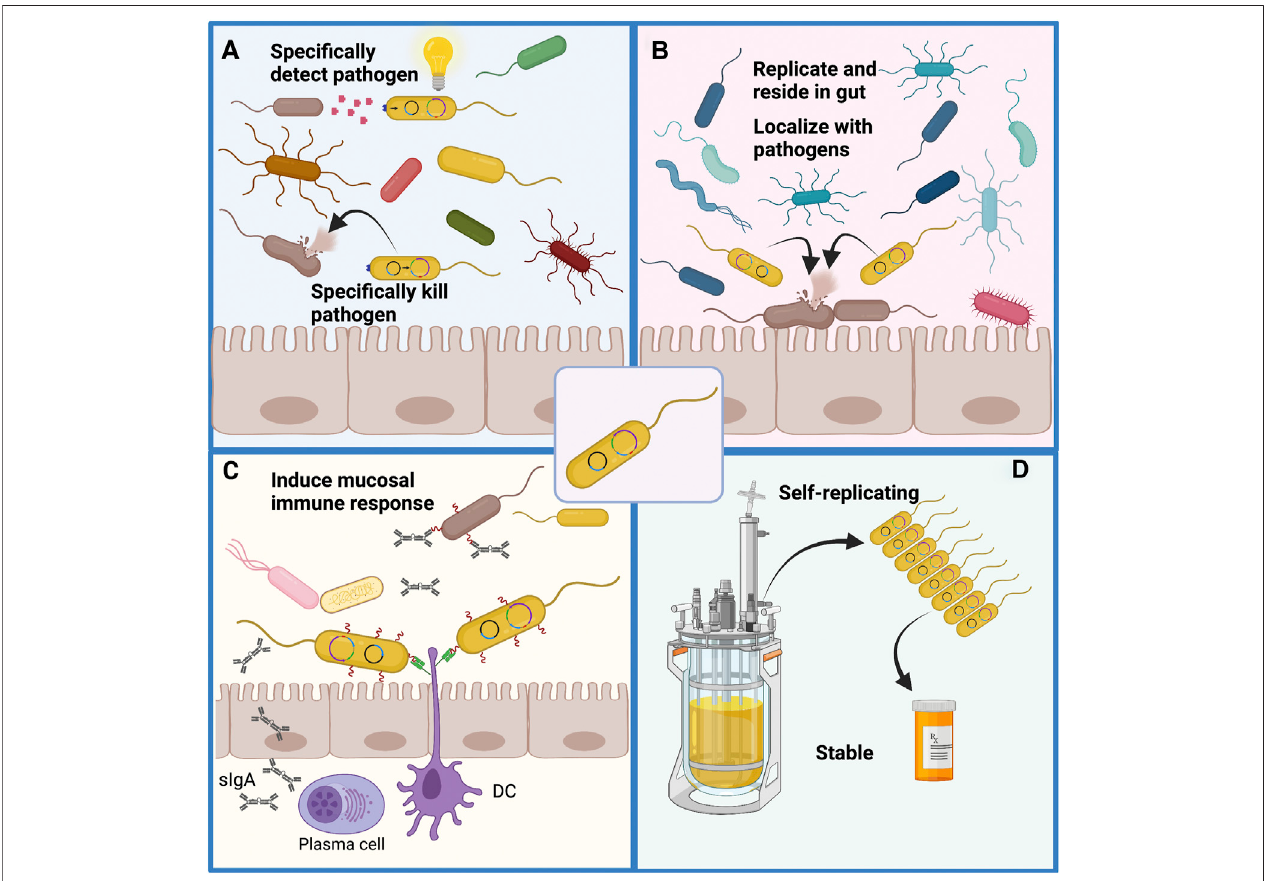
FIGURE4| Potential bene fi ts ofengineered livecell therapeutics. (A) Engineered probiotics havethe potential tobetrained todetect speci fi c pathogens bywayof signaling molecules, surface antigens, secreted metabolites or other small molecules unique to the pathogen. This high speci fi city may allow for selective killing of the pathogen without loss of the resident microbial population, thus avoiding the dysbiosis that results from administration of broad-spectrum antibiotic drugs. (B) An engineered probiotic would reside in the gut in close proximity to sites of infection to allow direct and speci fi c killing of intestinal pathogens with limited systemic effects. As the probiotic would self-replicate itwould be effectivefor aprolonged time without the need for multiple applications. (C) As alive-cell vaccine, probiotics can actasadeliveryvehicletosecreteordisplaypathogensurfaceantigens,adhesionmoleculesortoxinfragmentstoinducemucosalimmunityatthesiteofinfectionwhich may have bene fi ts over systemic immunization. (D) Engineered live-cell therapeutics can be produced in large quantity relatively cheaply through bioreactor culture and the cells can be stored dry or frozen with high viability.